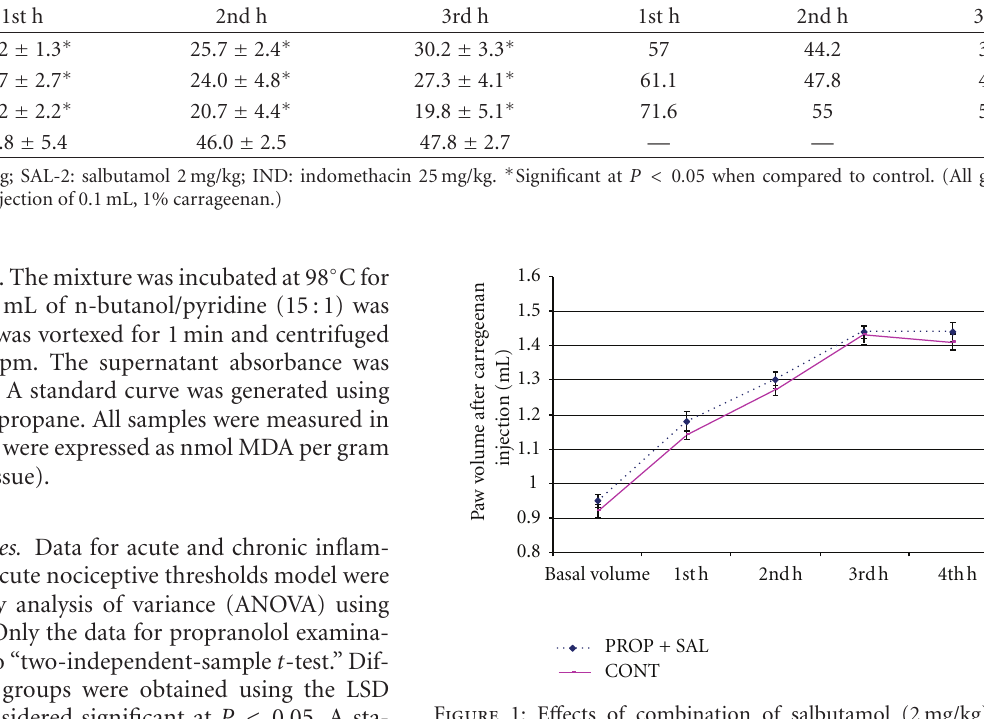
Table 2: E ff ects of salbutamol and indomethacin on carrageenan-induced inflammatory paw nociception in rats. Drugs